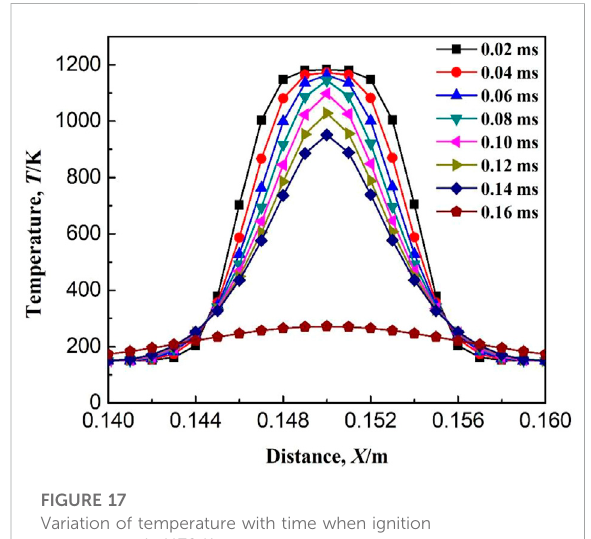
FIGURE 17 Variation of temperature with time when ignition temperature is 1170 K.